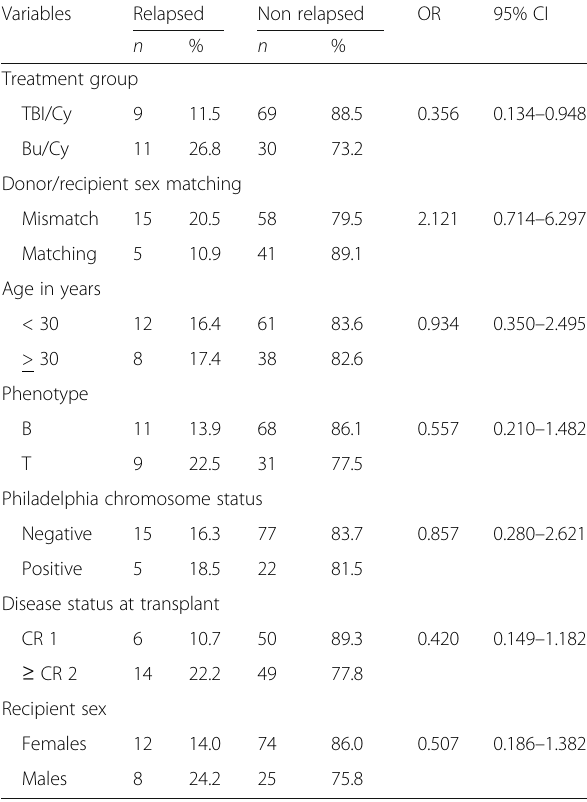
Table 4 Multivariate analysis of overall survival and disease-free survival